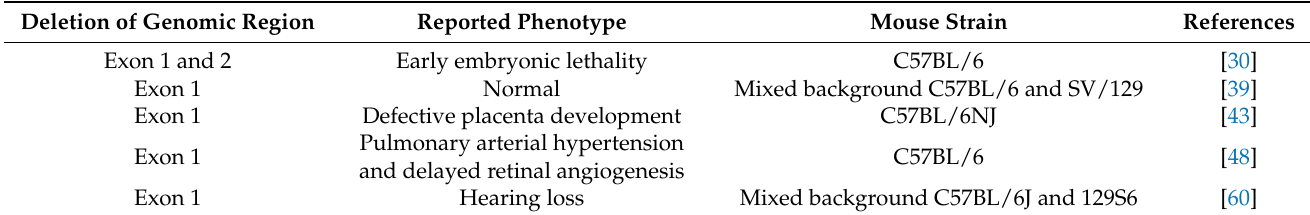
Table 1. List of Atoh8 mutant mice and observed